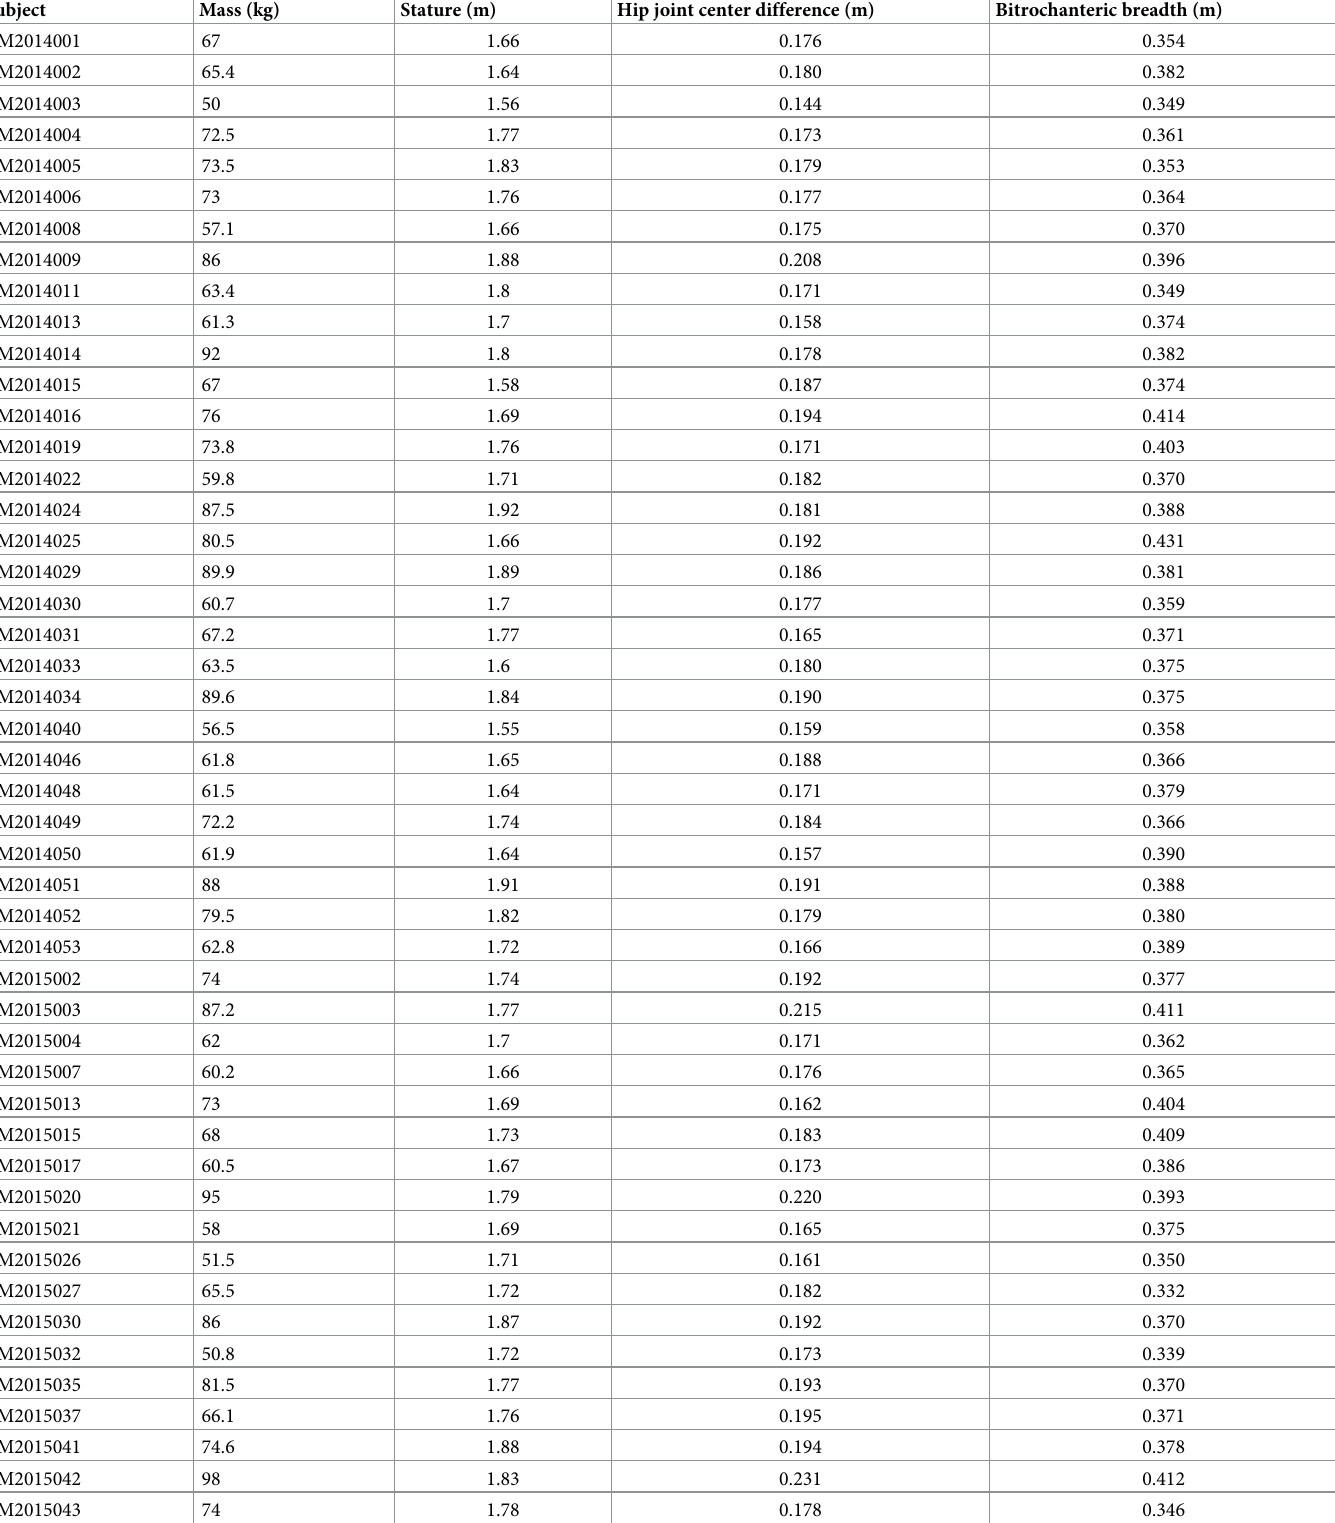
Table 2. Individual anthropometric characteristics. Mass and stature are from Schreiber and Moissenet (2019); hip joint center distance and bitrochanteric breadth cal- culated in the current